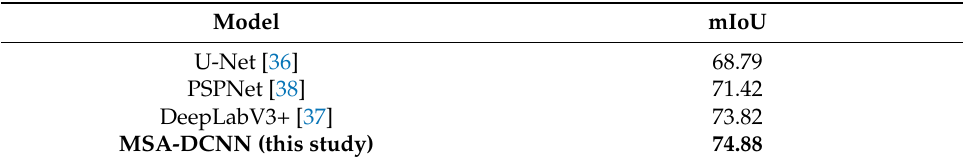
Table 8. Comparison of the